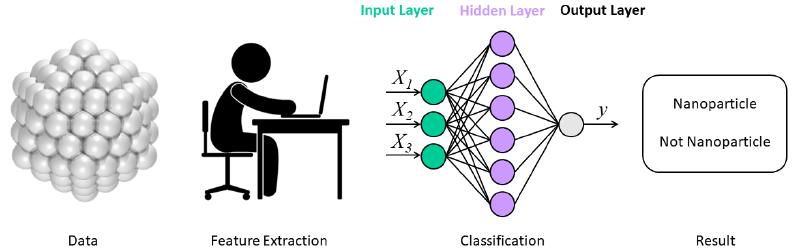
Figure 3. To predict the size distribution into a special structural identification of nanoparticle-like material by the classification model, the method of simple neural networks is used where researchers manually undertook feature extraction [96]. Copyright 2019 The Royal Society of Chemistry.